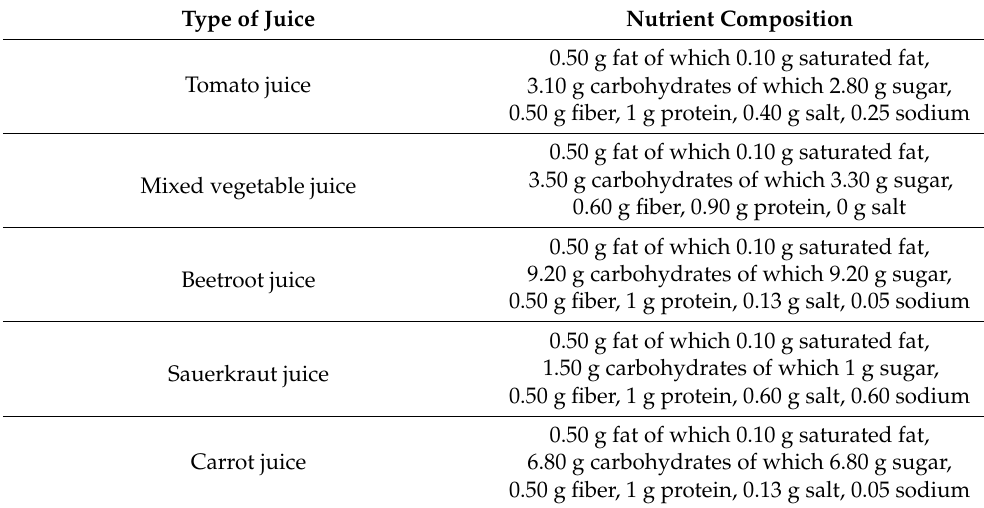
Table A2. Nutrient composition of the juices used in the